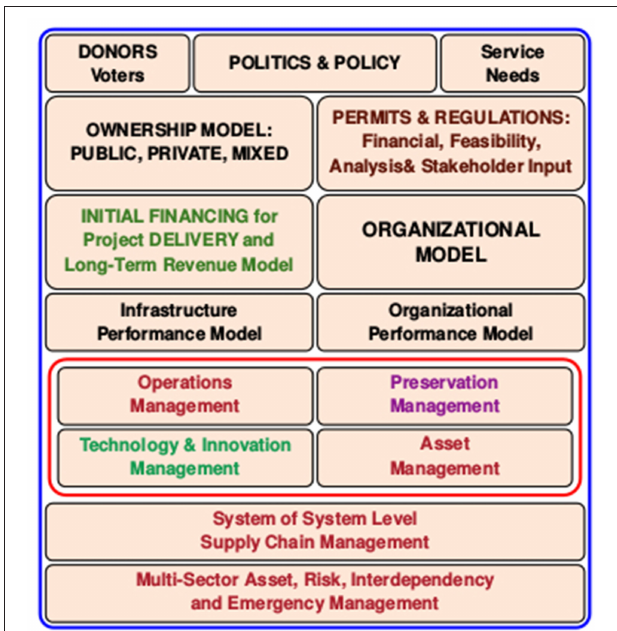
FIGURE 1 | System influencing management and performance of